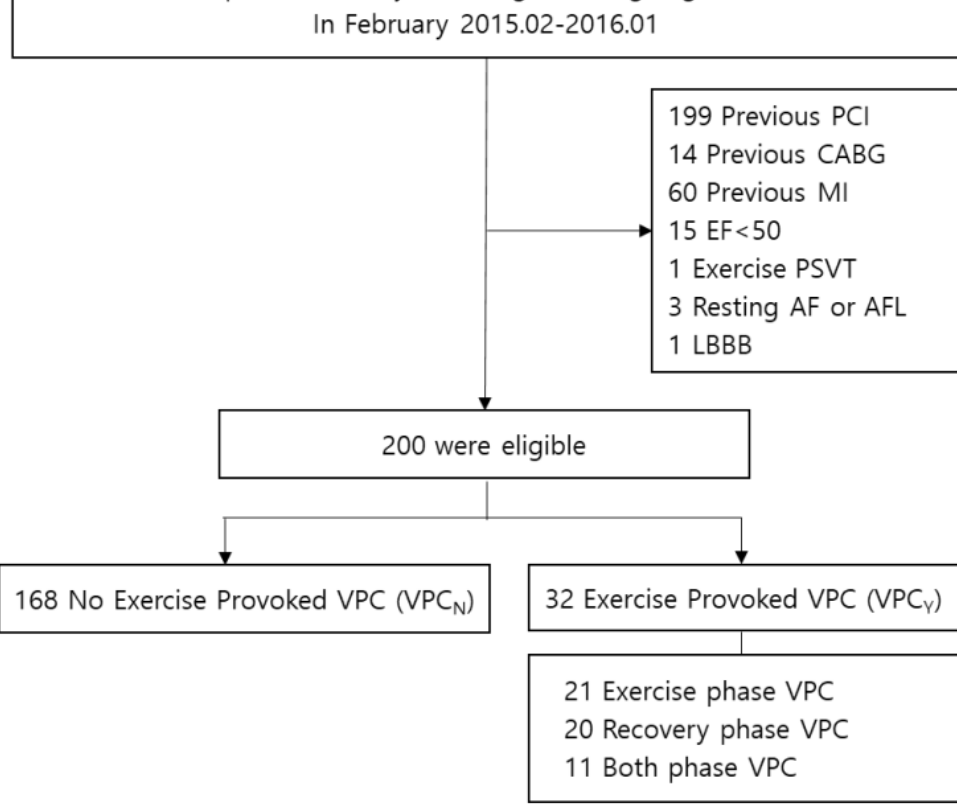
Figure 1. Study flow chart with number of patients.